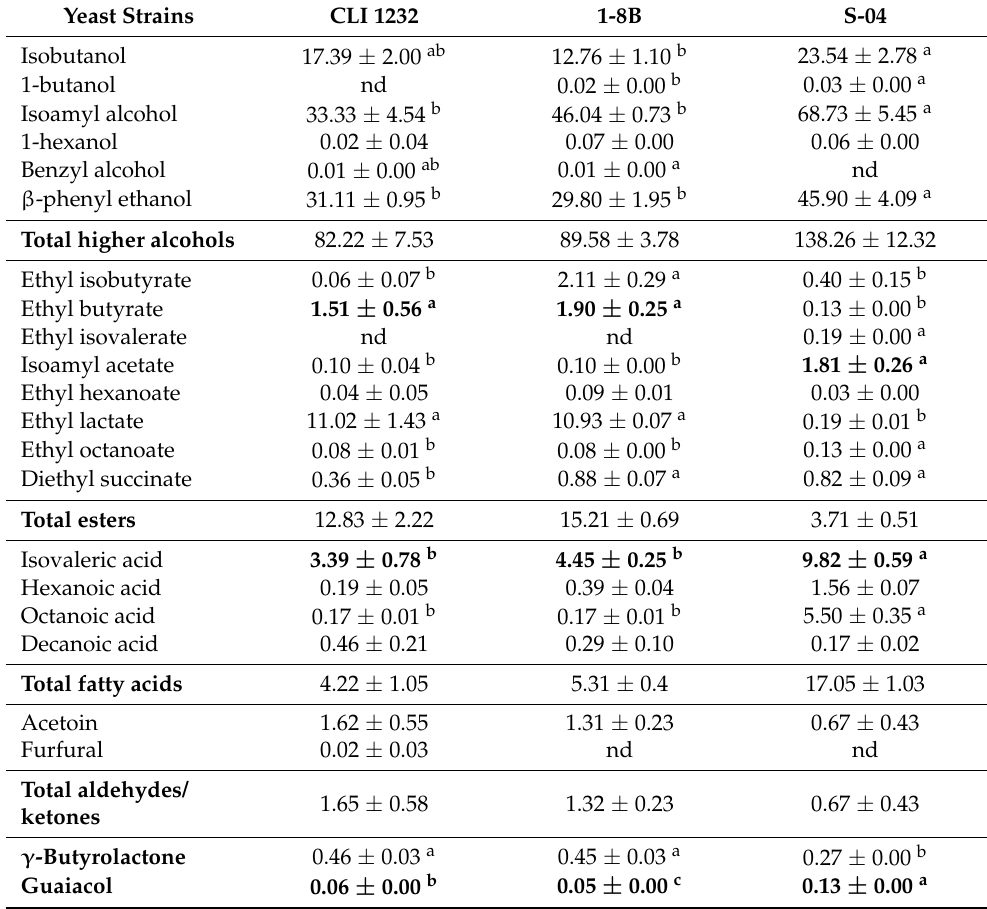
Table 4. Volatile compounds (mg L − 1 ) detected in beers fermented with CLI 1232 and 1-8B L. thermotolerans strains and control strain